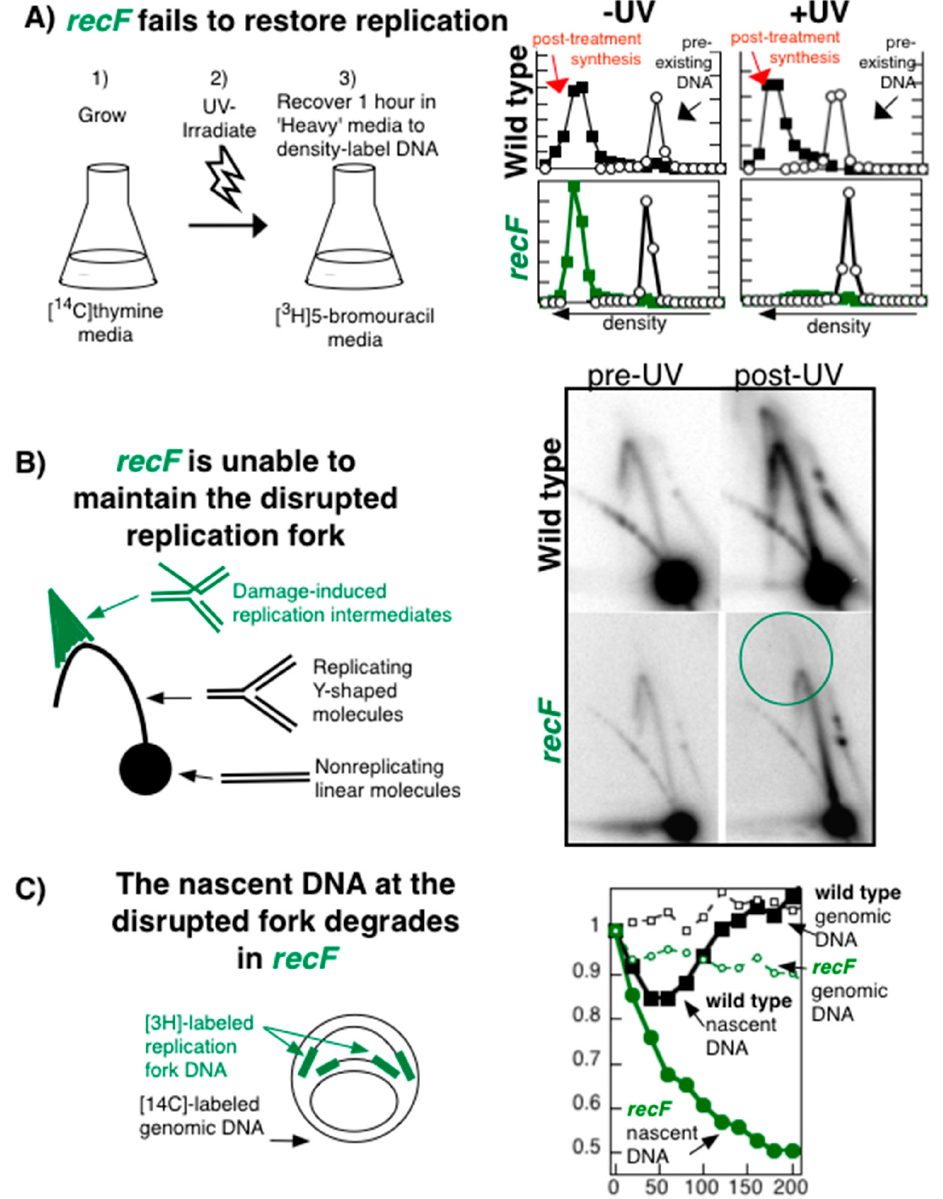
Figure 4. RecF is required to maintain replication forks disrupted by DNA damage. ( A ) recF mutants fail to restore replication following disruption by UV-induced damage . The amount of replication occurring within 1 h after UV irradiation with 25 J/m 2 was analyzed by alkaline CsCl density gradients. Cells prelabeled with [ 14 C]thymine were irradiated or mock-irradiated, filtered, and allowed to recover for 1 h in media containing [ 3 H]5-bromodeoxyuridine to density label DNA made during this period. Circles, 14 C prelabeled DNA; squares, 3 H replicated DNA. ( B ) recF mutants are unable to maintain the replication fork processing observed by two-dimensional gel electrophoresis . The migration pattern in 2D agarose gels for linearized pBR322 plasmid after UV treatment. Nonreplicating plasmids run as a linear 4.4 kb fragment. Normal replicating plasmids form Y-shaped structures and migrate more slowly due to their increased size and nonlinear shape, moving as an arc that extends from the linear fragment. Replication intermediates observed after UV damage form double-Y or X-shaped structures that migrate in the cone region. Whereas processing intermediates transiently accumulate in wild-type cells after UV irradiation, no intermediates are observed in recF mutants. ( C ) The nascent DNA undergoes excessive degradation in recF mutants . [ 3 H]thymidine is added to [ 14 C]thymine-prelabeled cells for 10 s immediately before the cells were filtered and irradiated with 25 J/m 2 in nonradioactive medium. The fraction of the radioactivity remaining in the DNA is plotted against time. Loss of 14 C genomic DNA (open symbols) can be compared to the loss of the 3 H DNA synthesized at the growing fork just prior to irradiation (filled symbols). Squares, wild type; circles, recF . Compiled and redrawn from data reported in [18,53].